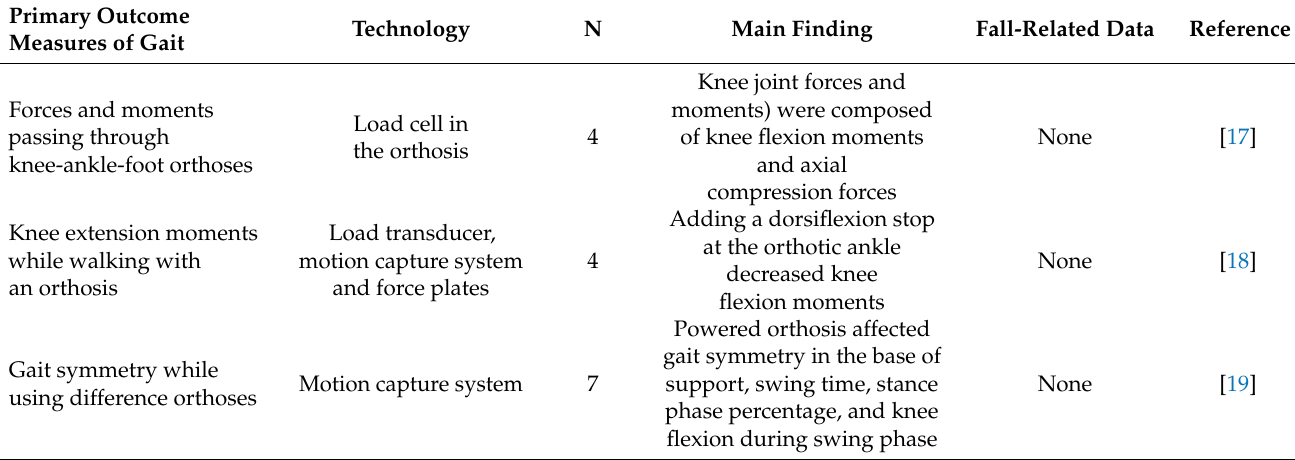
Table 1. Literature review of studies that performed instrumented gait analysis in post-polio syndrome (PPS) patients. single subject case-studies were not included in the